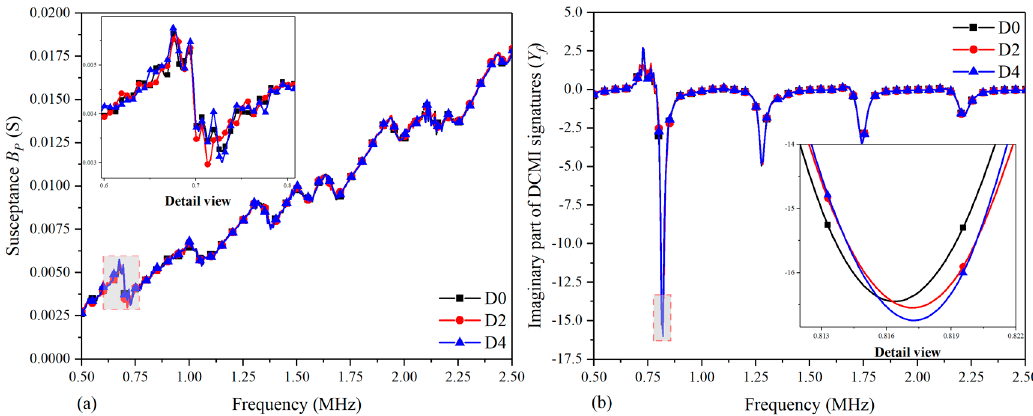
Figure 6. Comparative plots based on imaginary part of signatures for specimen-1: ( a ) raw signatures B P , ( b ) extracted DCMI signatures Y f B , ( b ) extracted DCMI signatures susceptance signatures P